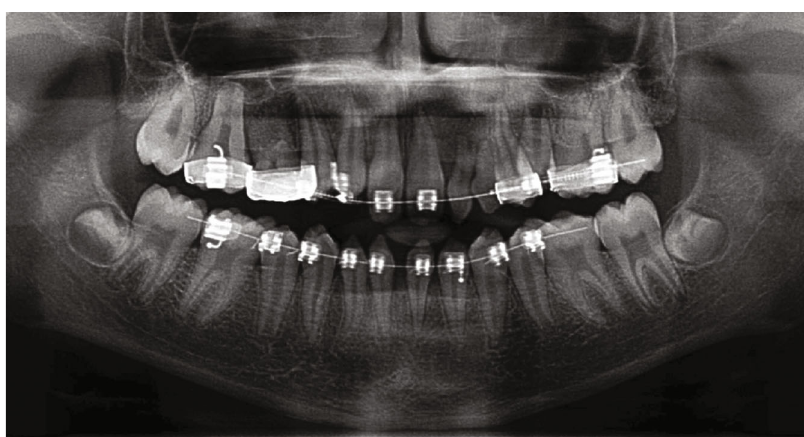
Figure 10: The “ near-end radiograph ” (digital dental panoramic tomograph).